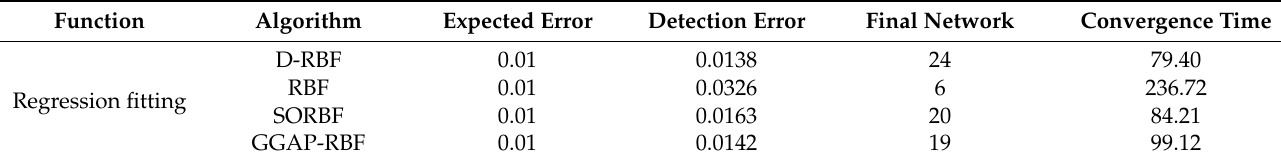
Figure 15. Error values of ten groups of test samples.